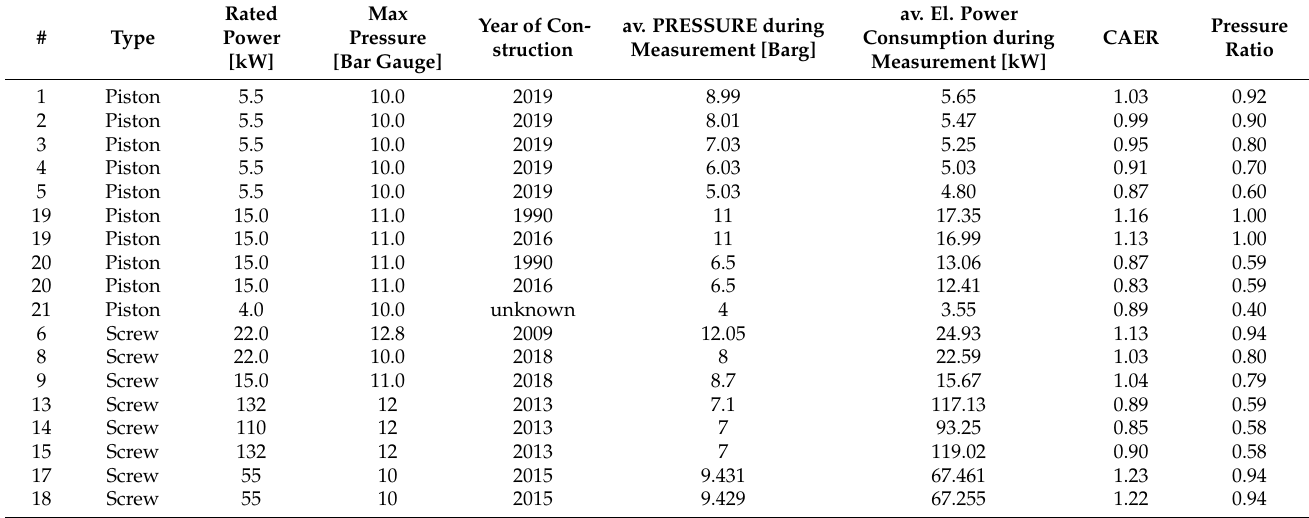
Table 2. Compressors without speed regulation (source: own representation).